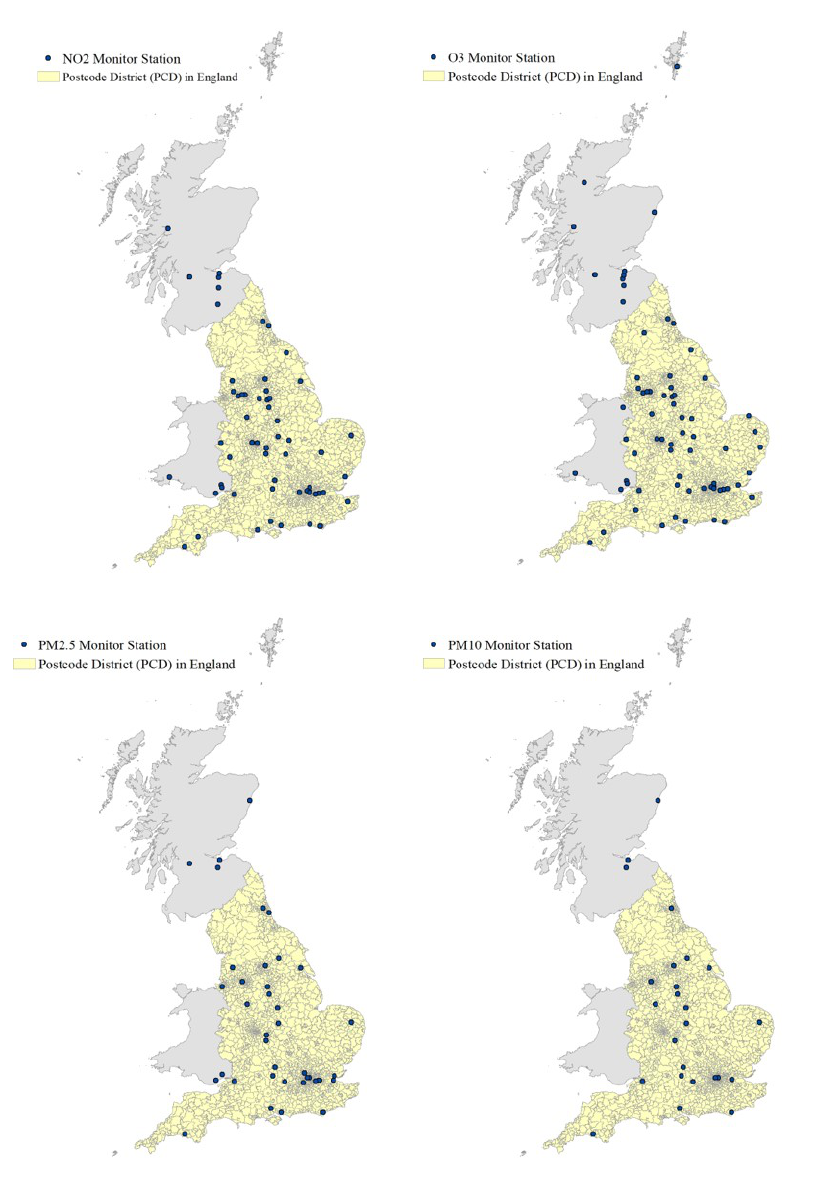
Figure 1. Spatial distribution of monitoring stations across Great Britain Whilst the comparisons of daily air pollution estimates are insightful, they are not representative of the precision of IDW in other locations, as the comparisons occurred at monitoring stations where the IDW estimates were calculated from. In order to assess the precision of IDW, we further explored the magnitude of any discrepancies through a “bench-marking” approach. The measurements at monitoring stations ( MON s) were considered true observations of air pollution exposure that we can use to compare against air pollution estimates derived from the other exposure assignment methods. Specifically, we were interested in the difference between these true observations and the concentrations derived using assignment methods. We applied the daily LUR model and IDW to obtain daily air pollution estimates, for all four pollutants, at each monitoring station, while excluding the station in question from its own measurement/estimation. For example, for IDW estimate at monitoring station A , we deliberately excluded measurements from A and used measurements from the second-nearest station, B . This was to mimic